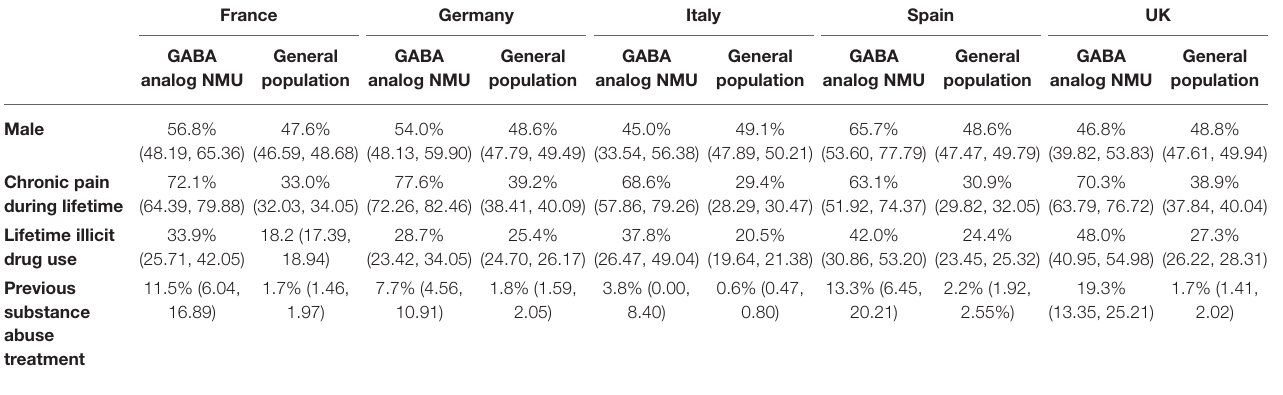
TABLE 2 | Demographics of those who have non-medically used GABA Analogs in the last 90 days vs. the general adult population demographics.